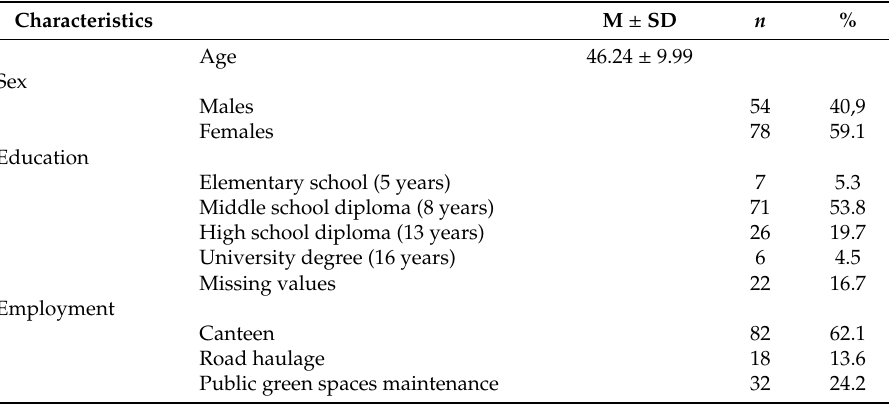
Table 1. Demographic characteristics of the sample ( n =